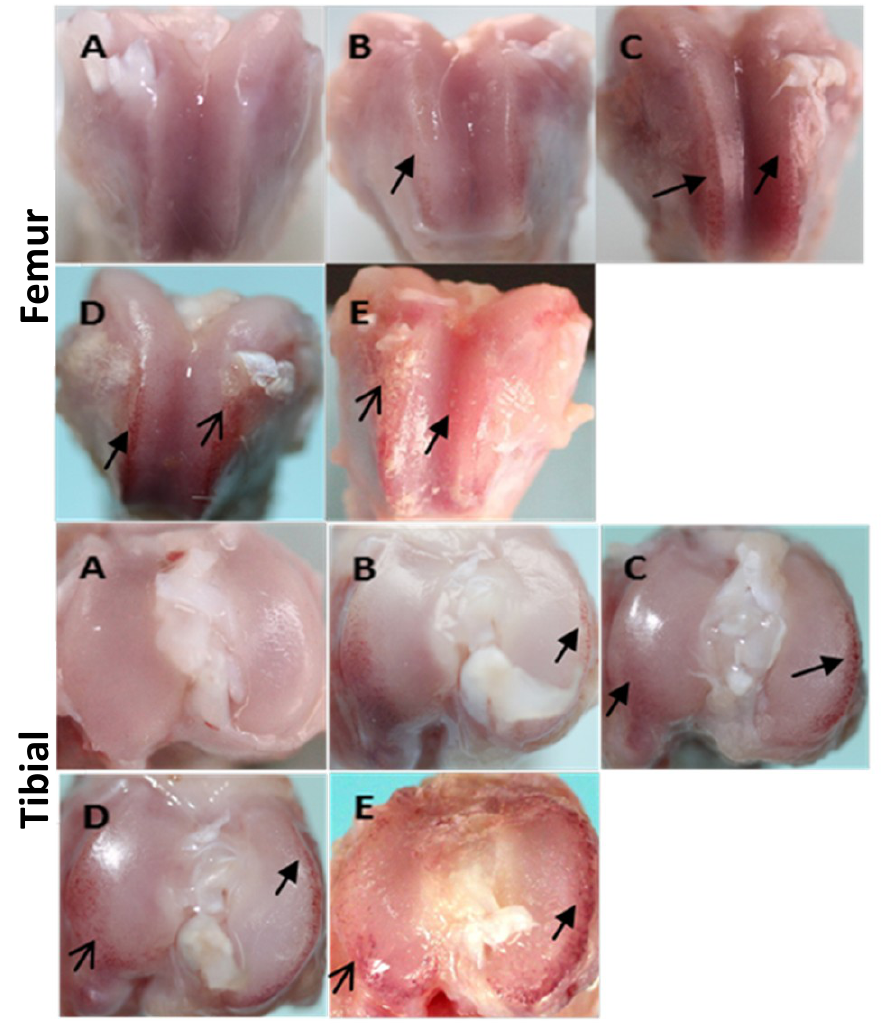
Figure 1. Outline of the distal femur and proximal tibial. ( A ) 1-month group; ( B ) 3-month group; ( C ) 6-month group; ( D ) 9-month group; and ( E ) 12-month group. Black solid arrow indicates ulceration, black arrow indicates